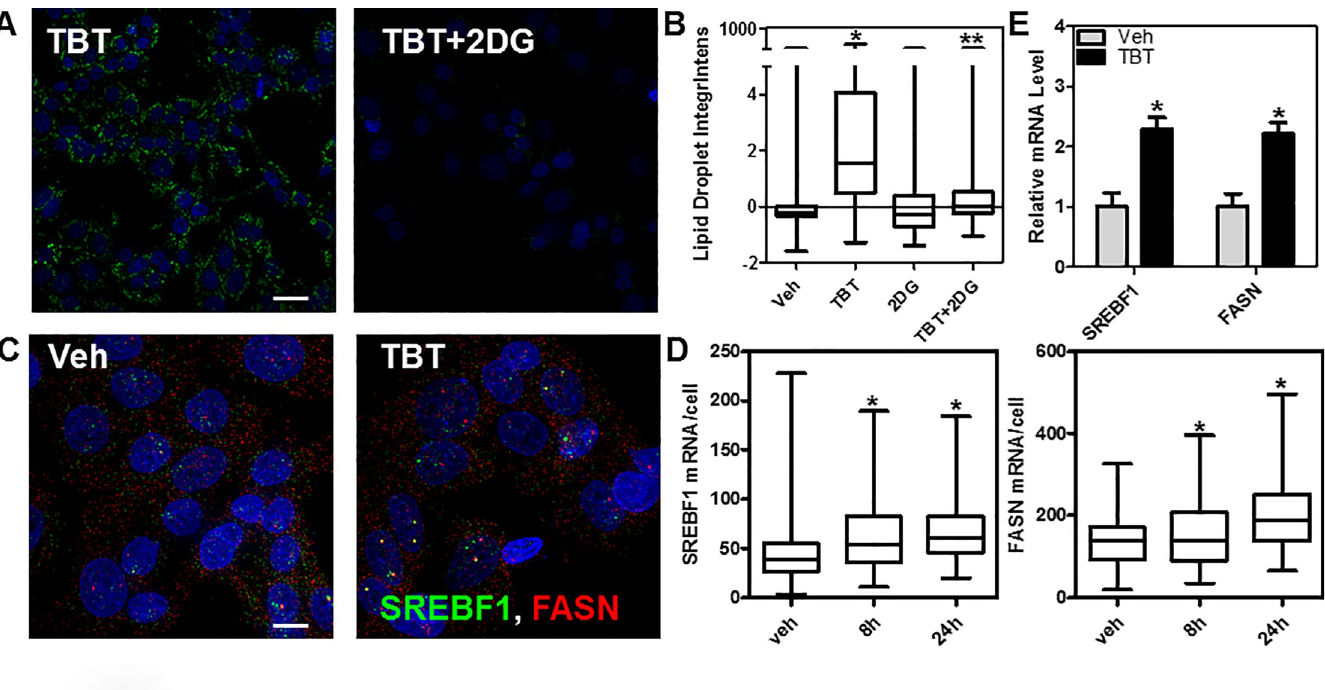
Fig 3. TBT increase in lipid droplets is mediated through glycolysis and activation of some lipogenic genes. A) HepaRG cells were grown in the presence of TBT (50 nM), 2-deoxyglucose (2DG, 2 mM) or vehicle for 3 days, then lipid content was analyzed as in Fig 1. Representative 40x images are shown. Scale bar: 25 μ m. B) quantification of images from the experiment performed in panel A, data is z-normalized based on vehicle (DMSO) treatment and shown as integrated intensity of lipid droplets/cell. � p < 0.01 compared to Vehicle; �� p < 0.01 compared to TBT. C-D) Single molecule RNA FISH for SREBF1 and FASN was performed in HepaRG cells after 8 and 24 h (shown in the panels) of TBT or vehicle treatment. Images (60x/1.4NA) shown are max projections after deconvolution. In panel D, the number of single RNA molecules/cell was counted and represented as a box plot. Scale bar: 10 μ mM. E) RT-qPCR validation of TBT induction of SREBF1 and FASN mRNAs after 24h of 50nM TBT treatment. � p < 0.01 compared to